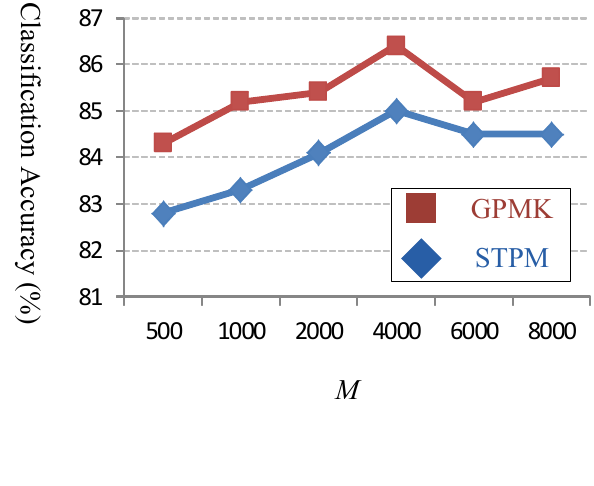
Figure 7. The classification accuracy (shown on the Y-axis) w.r.t. different values of M (shown on the X-axis) on Youtube dataset. The red square markers and the blue diamond ones correspond to our GPMK and the STPM kernel,